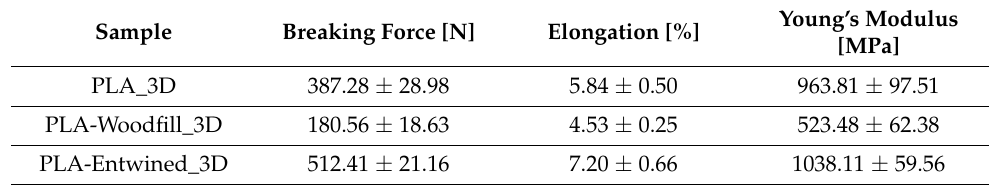
Table 5. Mechanical properties of 3D printed samples at room temperature; mean value ± SD.